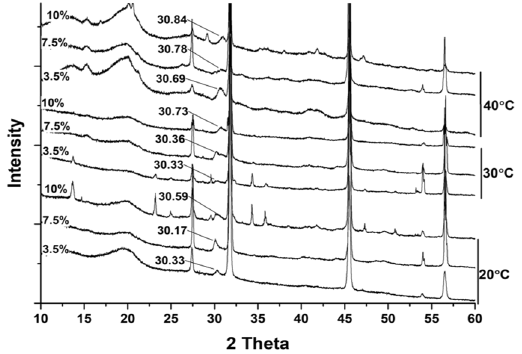
Figure 5. Representative X-ray diffraction patterns of minerals recovered from Virgibacillus cultures using media with different salinity levels, and temperatures and with a Mg 2 + : Ca 2 + ratio of 6. Adapted from corresponding PhD Dissertation 71 .